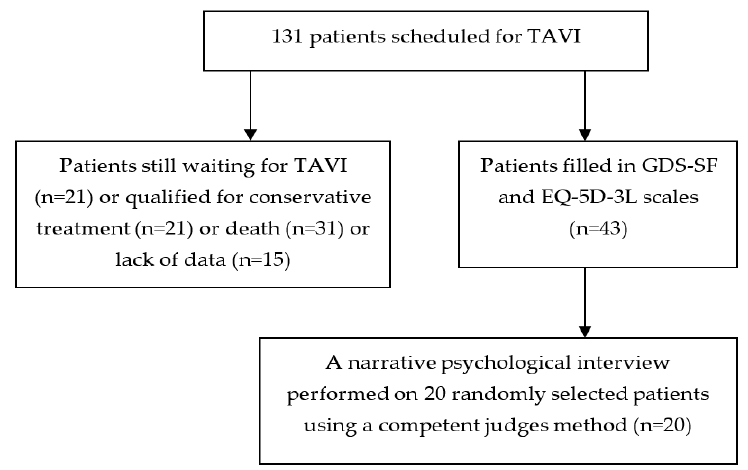
Figure 1. Flow chart of patients with severe aortic stenosis qualified for TAVI. Table 1. Demographic and clinical characteristics of the elderly patients scheduled for TAVI.